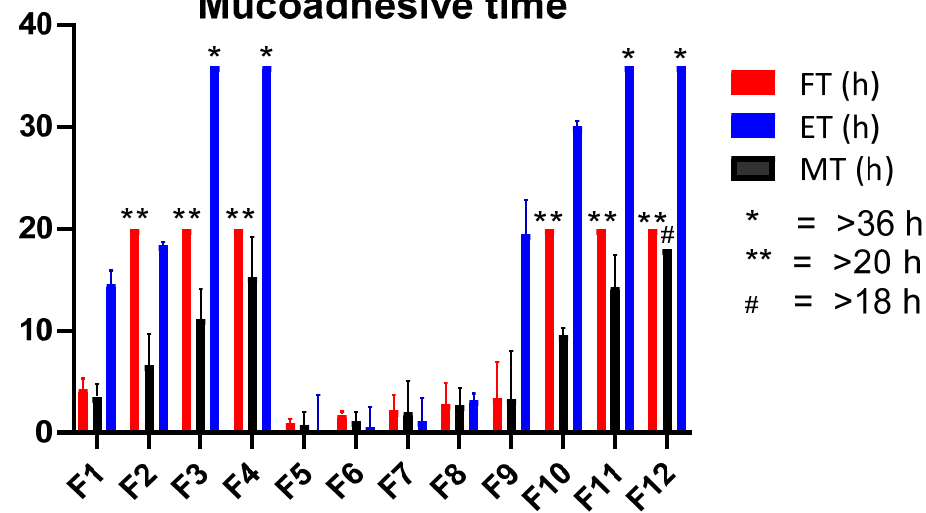
Figure 10. Comparison of the different mucoadhesive time properties of fabricated scaffold gel.